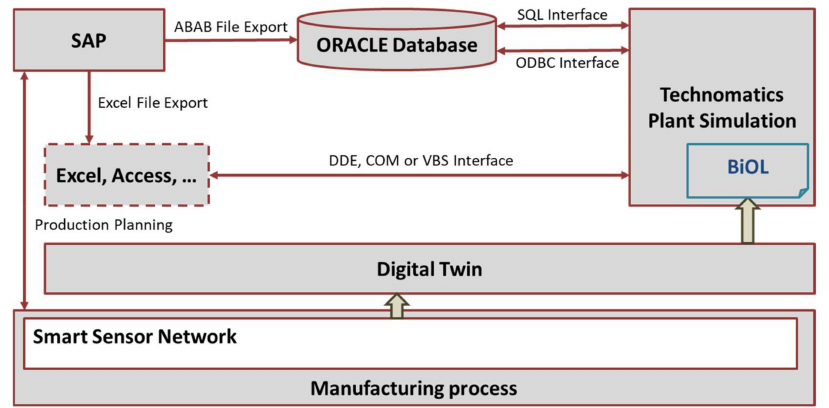
Figure 11. Practical applicability of the proposed methodology for integrating SAP and Technomatix Plant